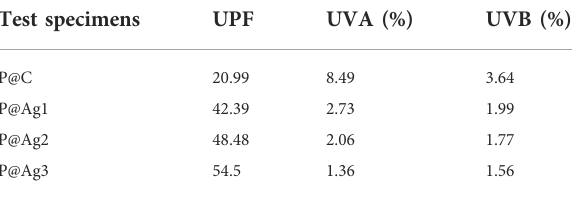
TABLE 9 UV-protection properties of control and AgNP coated papers.